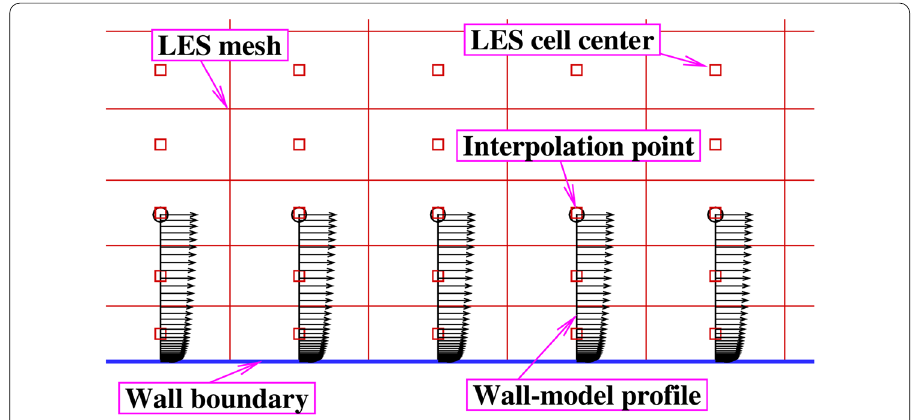
Fig. 1 Sketch of the LES grid and wall model